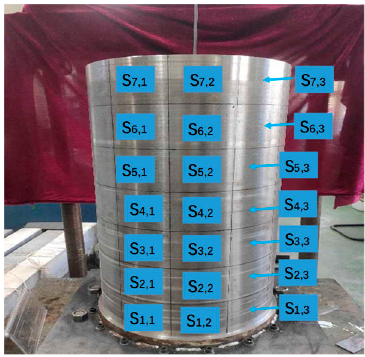
Figure 15. Tank model. Appl. Sci. 2020 , 10 , x FOR PEER REVIEW